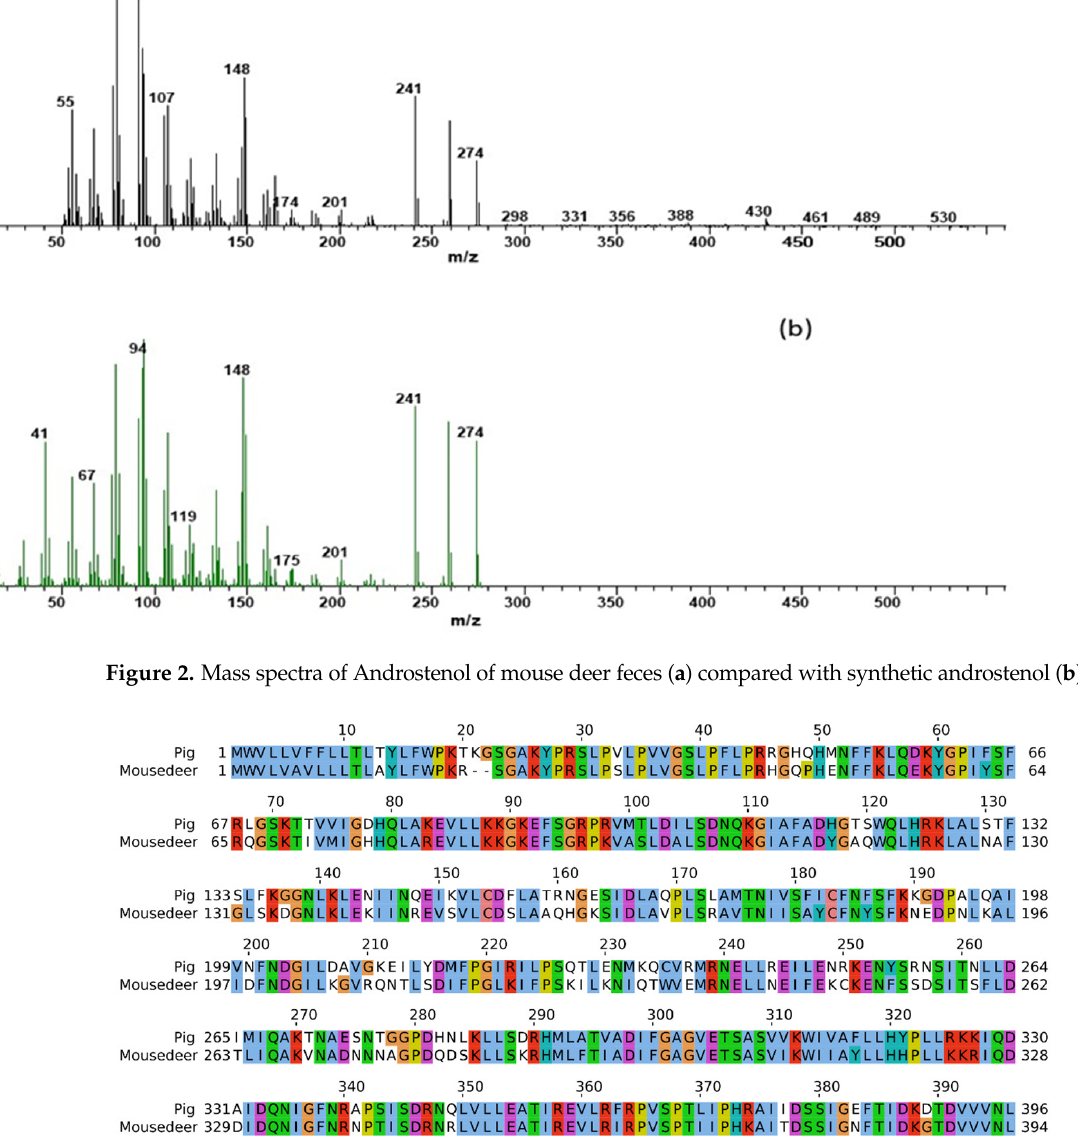
Figure 1. Mass spectra of Androstenone of mouse deer feces ( a ) compared with synthetic andros- tenone ( b ).